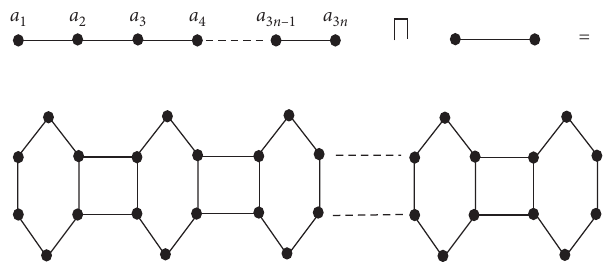
Figure 2: The linear phenylene F